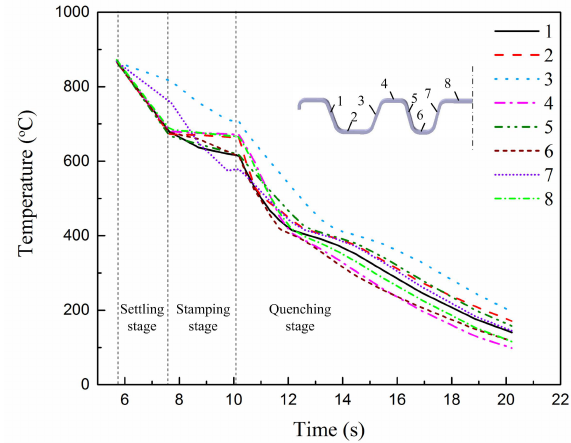
Figure 8. Temperature histories at different positions during hot stamping.